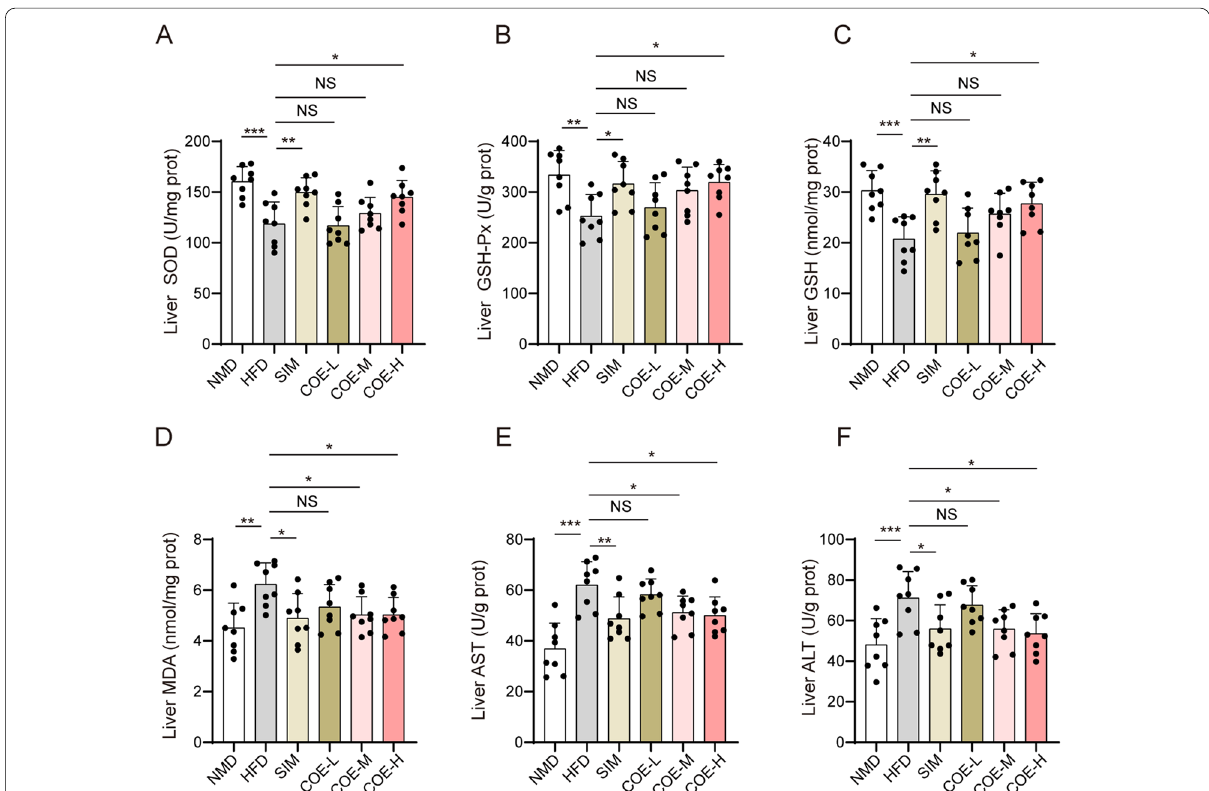
Fig. 5 Effects of COE on antioxidase activities and liver function. SOD ( A ), GSH-Px ( B ), GSH ( C ), MDA ( D ), AST ( E ), and ALT ( F ) levels were examined in hepatic tissues of hyperlipidemia rats treated with COE or SIM. n